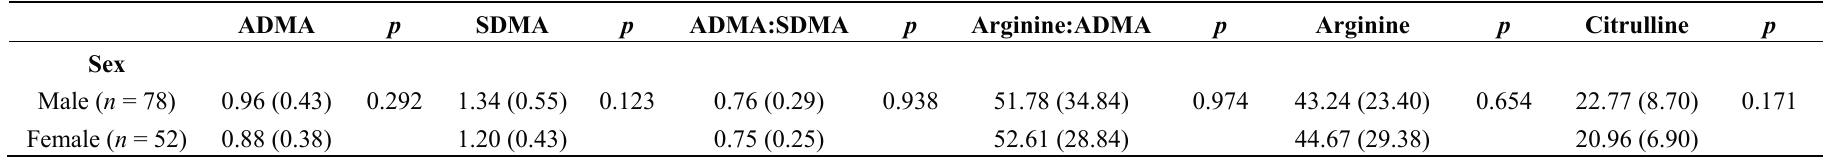
Table 4. Effects of sex and perinatal factors on dimethylarginines, arginine, citrulline levels and ratios in very low birth weight